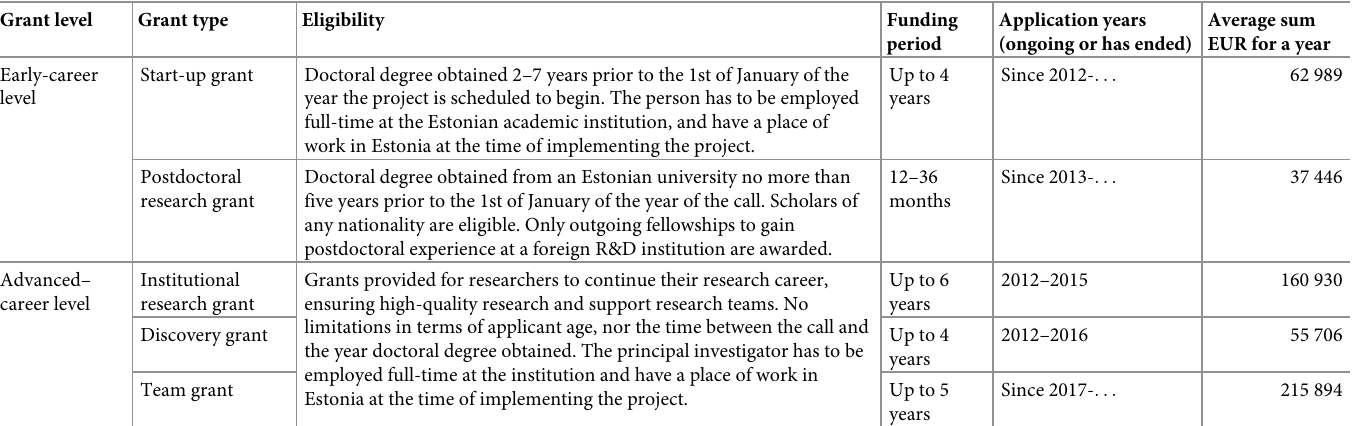
Table 1. Description of Estonian national grant